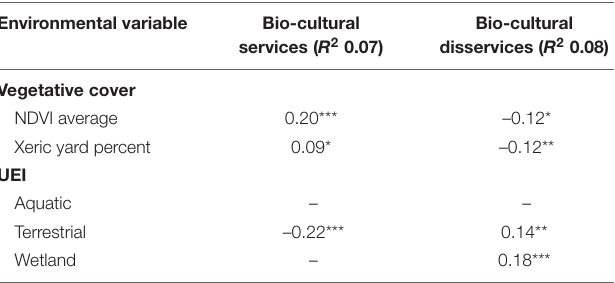
TABLE 6 | Environmental models at the broadly classified UEI level predicting perceptions of bio-cultural services and